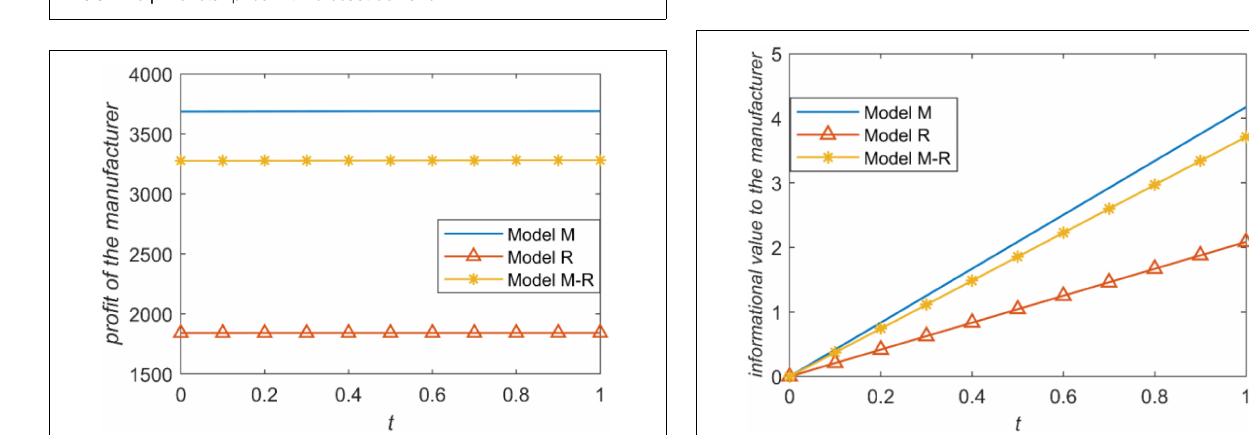
FIGURE 3 | The retail price with forecast demand.